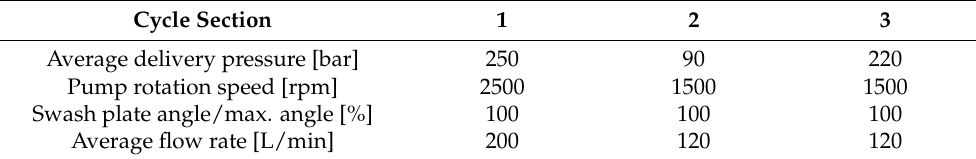
Table 2. Pump working conditions in second simulation